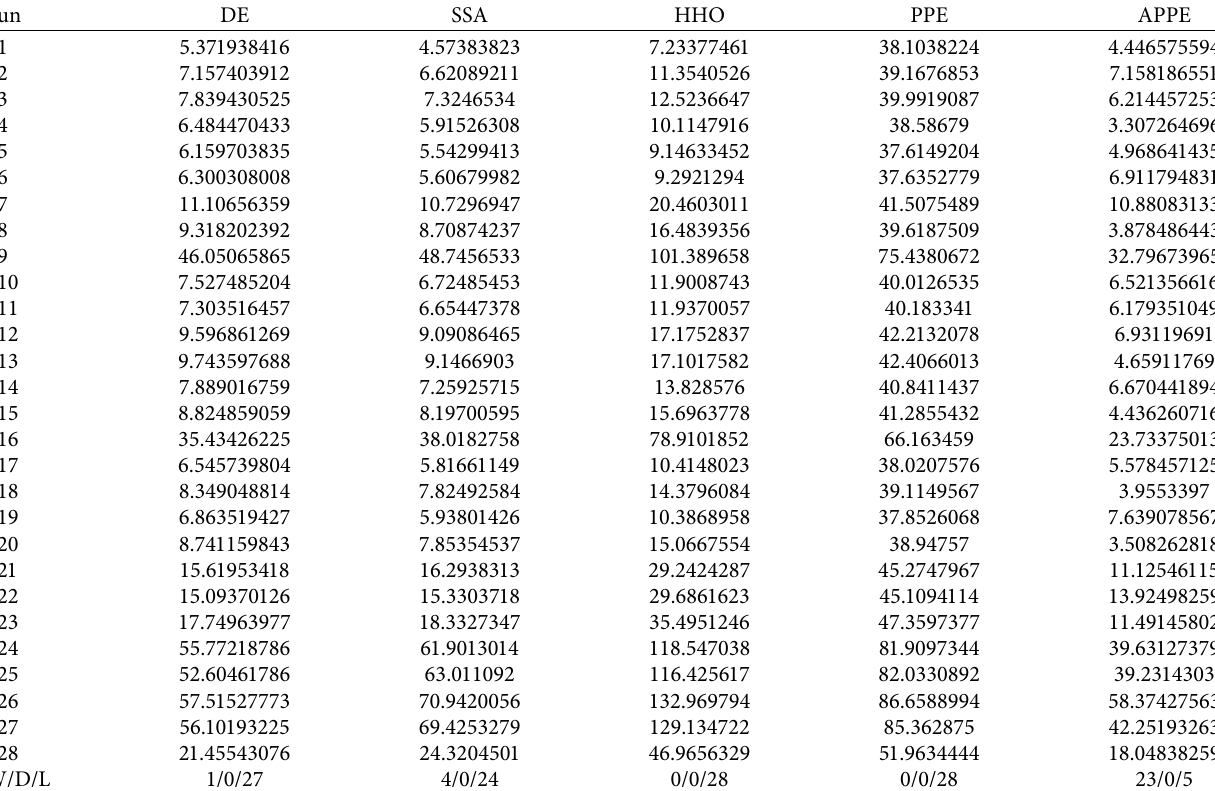
Table 13: Comparison of the average running time result of 51 runs on 50D in 28 benchmark